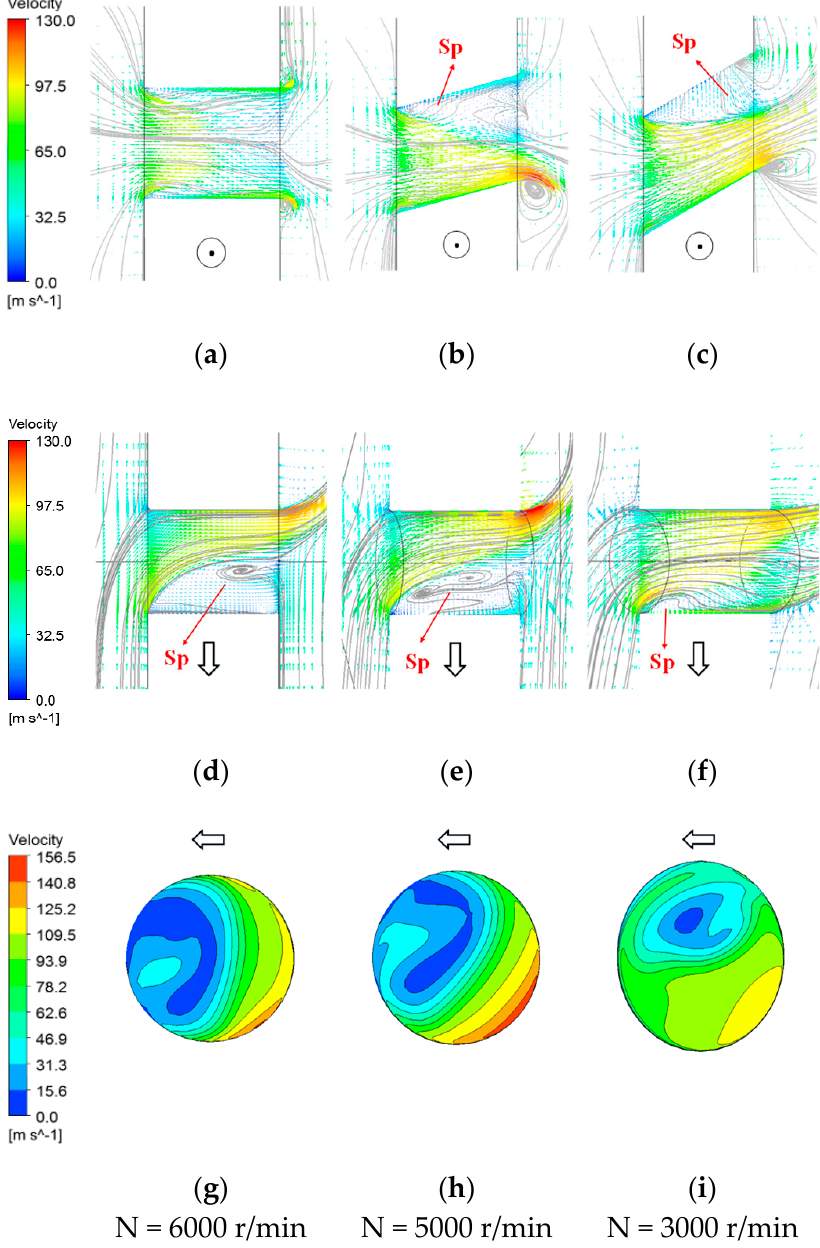
Figure 26. Streamlines and velocity contours of different sections for the orifice with similar i . ( a – c ) Meridian section; ( d – f ) circumferential cross-section; ( g – i ) velocity contour of the exit section. ( a , d , g ) α 0 = 0 ◦ , i = − 35.7 ◦ , C d = 0.378, ( b , e , h ) α 0 = 15 ◦ , i = − 34.3 ◦ , C d = 0.460, ( c , f , i ) α 0 = 30 ◦ , i = − 33.9 ◦ , C d =